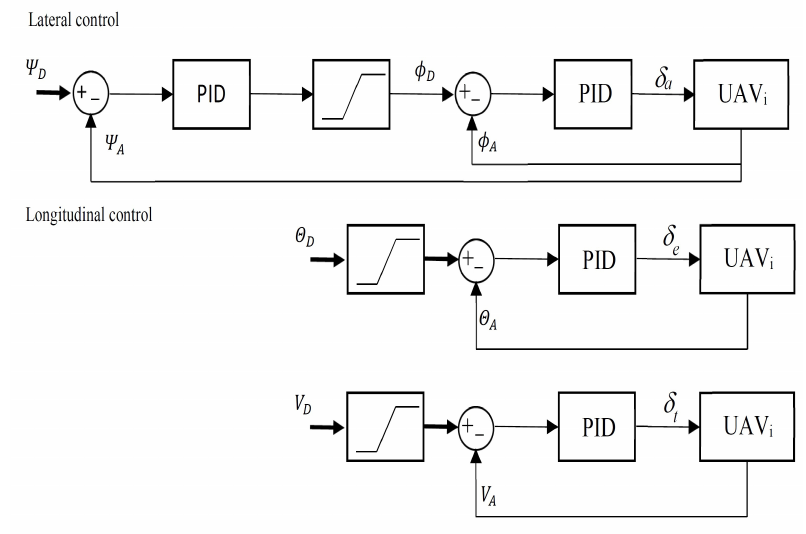
Figure 5. The structure of lateral and longitudinal control of a UAV. Ψ D —the desired heading from Equation (16), Ψ A —the actual heading, φ D —the desired roll angle, φ A —the actual roll angle, δ a — aileron’s deflection, θ D —the desired pitch angle from Equation (17), θ A —the actual pitch angle, δ e —elevator deflection, V D —the desired airspeed from (18), V A —the actual airspeed, and δ t —throttle.